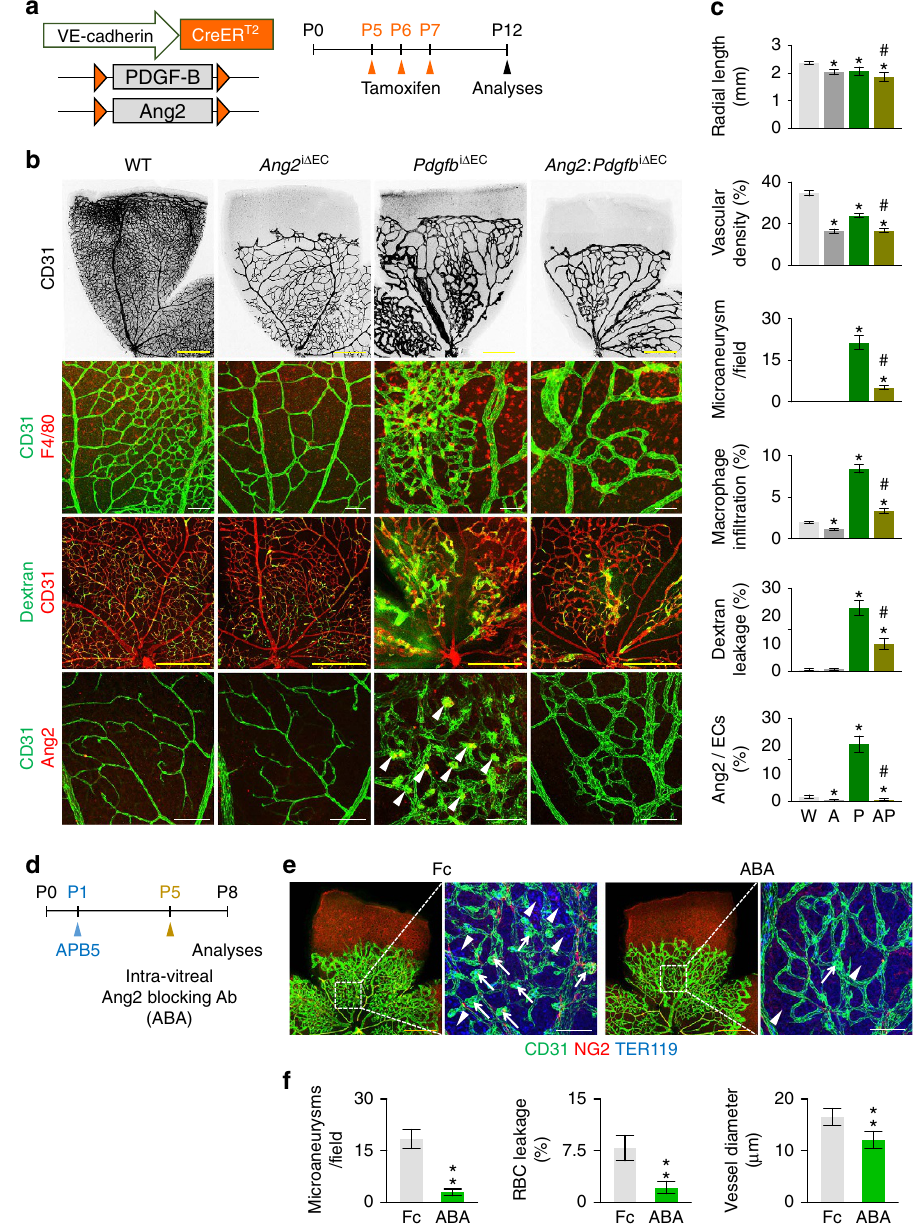
Figure 7 | Ang2 blockade ameliorates pericyte loss-induced BRB impairments. ( a ) Diagram depicting the experiment schedule for EC-specific depletion of PDGF-B and Ang2 in retinal vessels from P5 and their analyses at P12 in WT (W), Ang2 i D EC (A), Pdgfb i D EC (P), and Ang2:Pdgfb i D EC (AP) mice. ( b ) Images of CD31 þ retinal vessels, F4/80 þ macrophage infiltration, FITC-conjugated dextran (2,000kDa) leakage, and expression and localization of Ang2 in each group. Note that abnormalities such as increased macrophage infiltration, vascular leakage, or microaneurysm (arrowheads) formation in Pdgfb i D EC mice are greatly reduced in Ang2:Pdgfb i D EC mice. ( c ) Comparisons of indicated parameters in each group ( n ¼ 6). Error bars represent mean ± s.d. * P o 0.05 versus W, # P o 0.05 versus P by Kruskal–Wallis test. ( d ) Diagram depicting the experiment schedule for intravitreal injection of Ang2 blocking antibody (ABA) at P5 in WTmice that were treated with APB5 at P1, and their analyses at P8. ( e , f ) Images and comparisons of CD31 þ vessels, NG2 þ pericytes, microaneurysms (arrows), and TER119 þ RBC leakages (arrowheads) in mice treated with Fc ( n ¼ 6) or ABA ( n ¼ 6). Error bars represent mean ± s.d. ** P o 0.01 versus Fc by Mann–Whitney U test. Scale bars, 100 m m (white) and 500 m m (yellow).